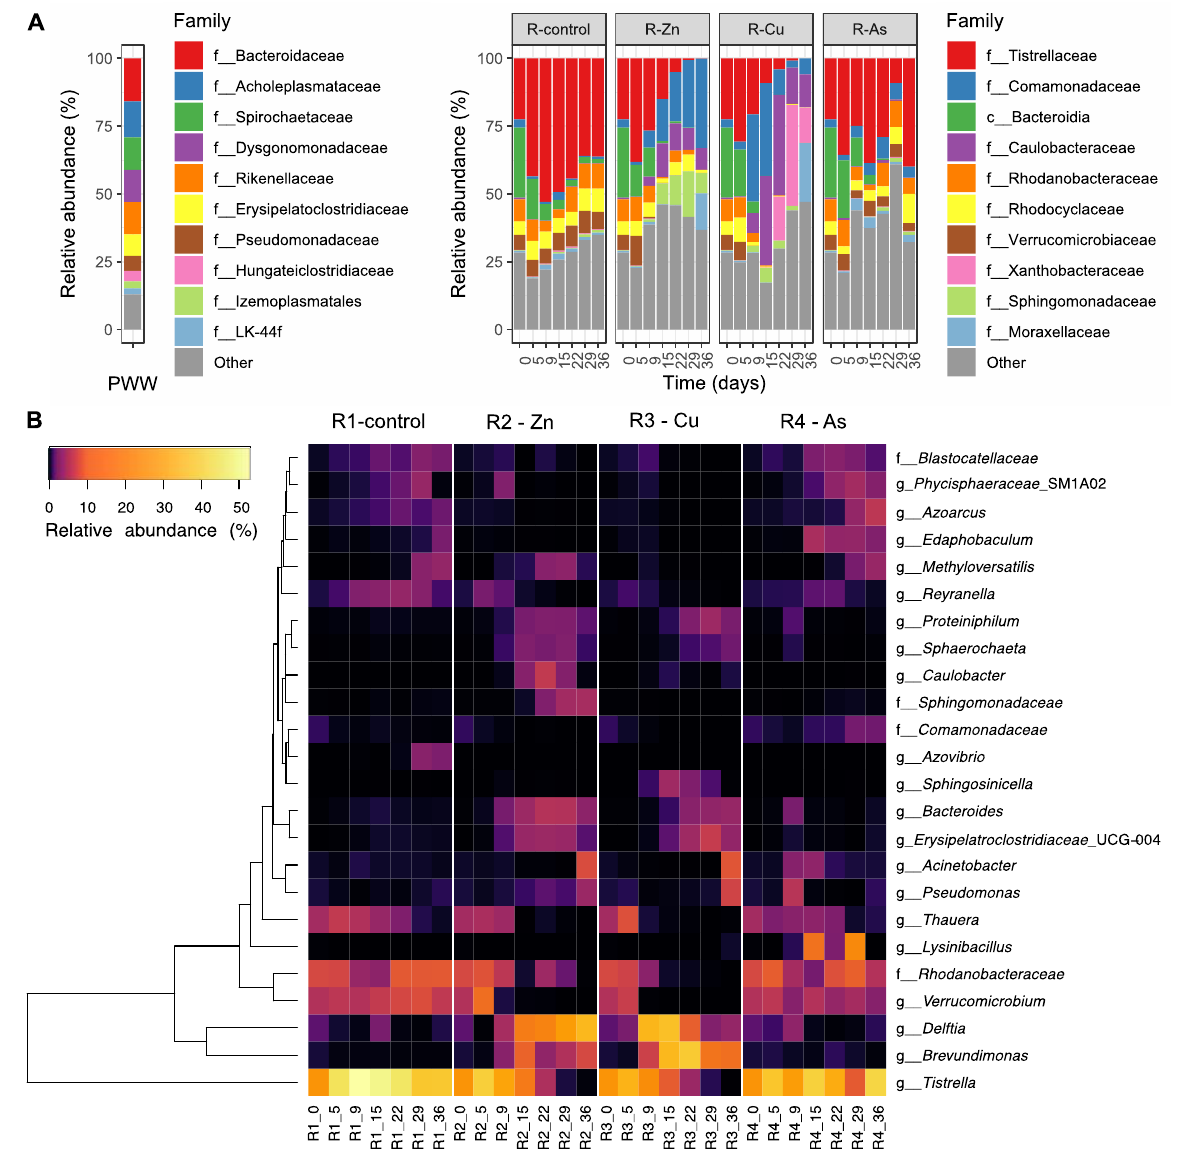
Figure 4. Bacterial community composition of the 10 most abundant taxa in the feed and PBRs at the family taxonomic level ( A ). The composition of the feed before dilution is shown (PWW, left). In the case of the PBRs, changes over time are shown for each reactor (right). Heatmap of bacteria differentially distributed among PBRs ( B ). The rows represent the bacterial genera found in the SIMPER analysis grouped according to the similarity of their relative abundance patterns. The columns represent the samples, which are labeled with the reactor and day. Cell color indicates bacteria relative abundances.